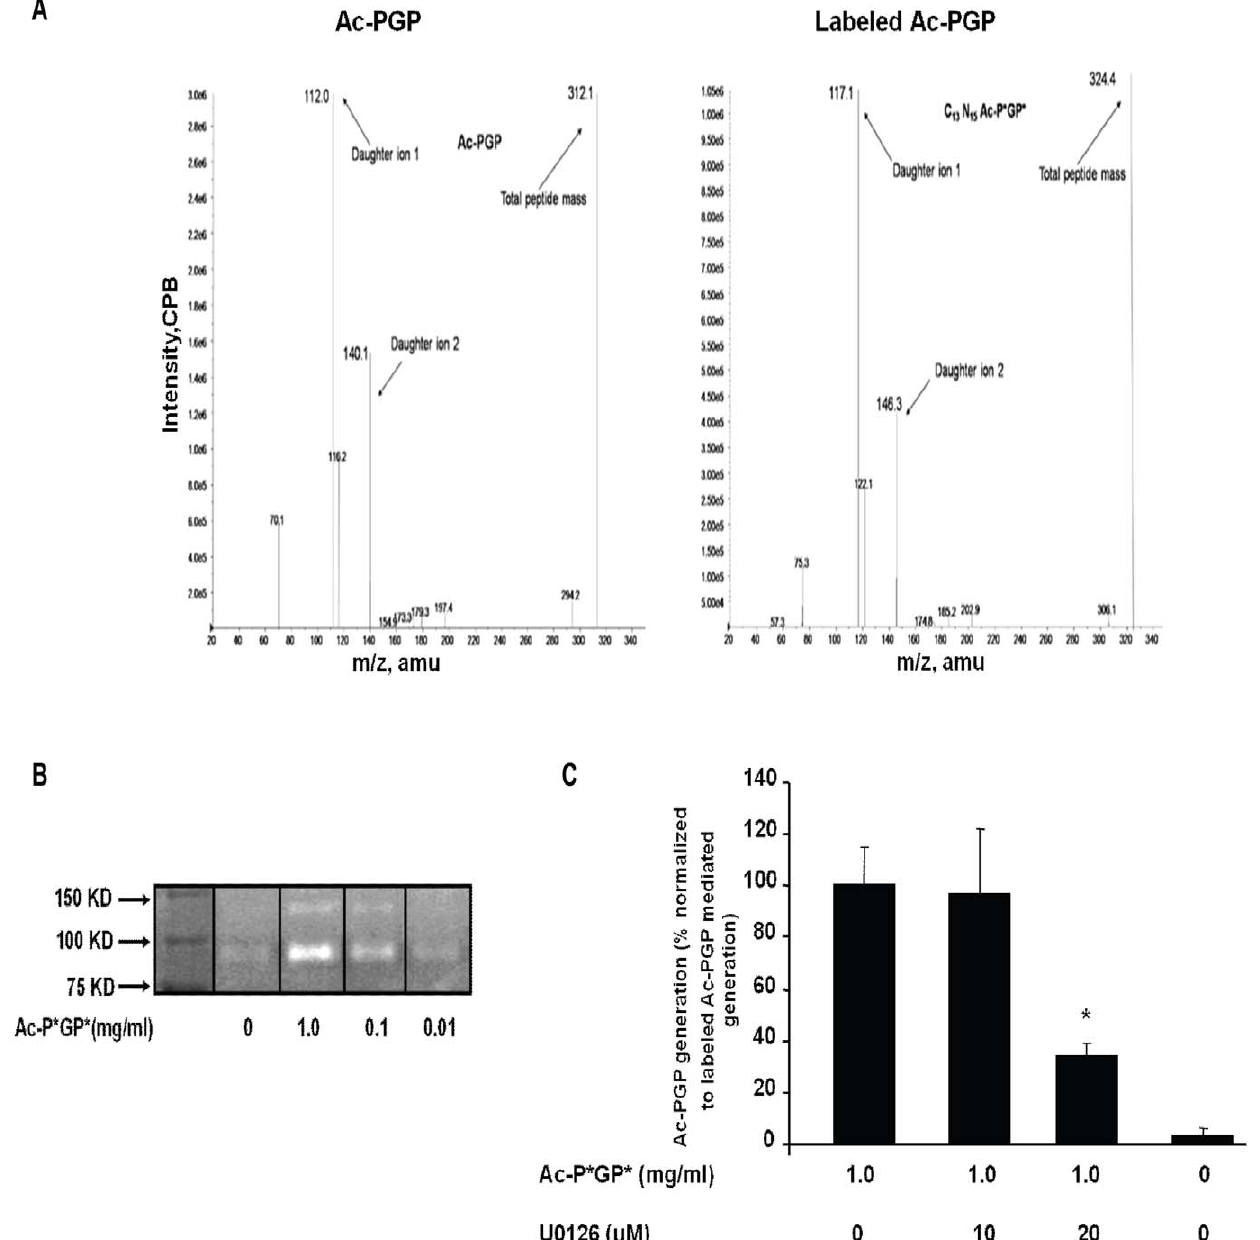
Figure 4. The blockade of ERK1/2 MAPK activation inhibited Ac-PGP production. Human peripheral blood PMNs (5.25 6 10 5 ) were pretreated with U0126 (10 and 20 m M) versus vehicle for 30 minutes and then incubated for 30 minutes with labeled Ac-PGP. The supernatants collected from incubated cells were placed on type I collagen (1.0 mg/ml) for 24 hours at 37 u C. Ac-PGP and C 13 N 15 labeled Ac-PGP were analyzing by ESI-LC-MS/MS . Ac-PGP values of the samples on PBS were subtracted from Ac-PGP values of samples incubated on type I collagen to determine Ac- PGP production. A . Detection of Ac-PGP and C 13 N 15 Ac-PGP via mass spectrometry. B . The detection of gelatinolytic activity in culture supernatants from human PMNs stimulated with labeled Ac-PGP by g elatin zymography representative of three gels. C . The measurement of Ac-PGP production